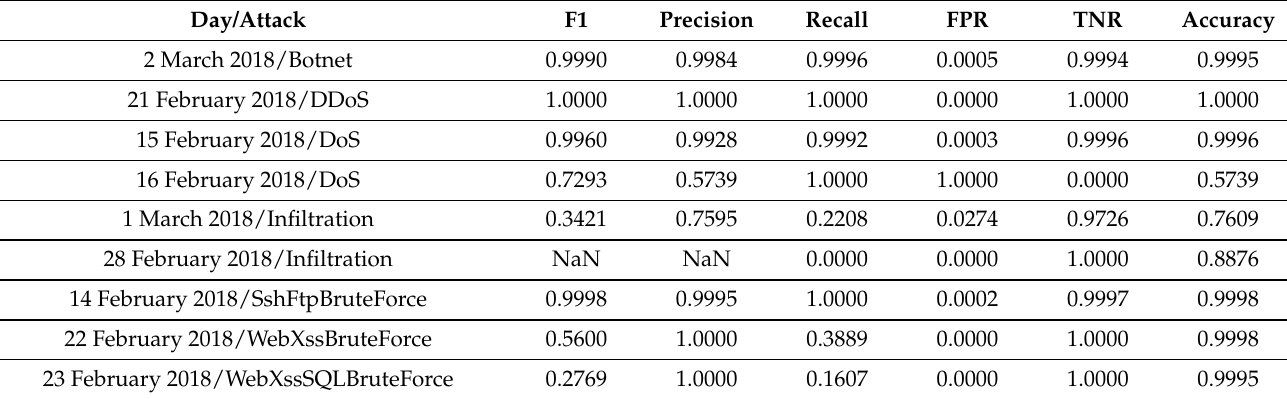
Table 9. Results obtained with a training CNN and autoencoder.